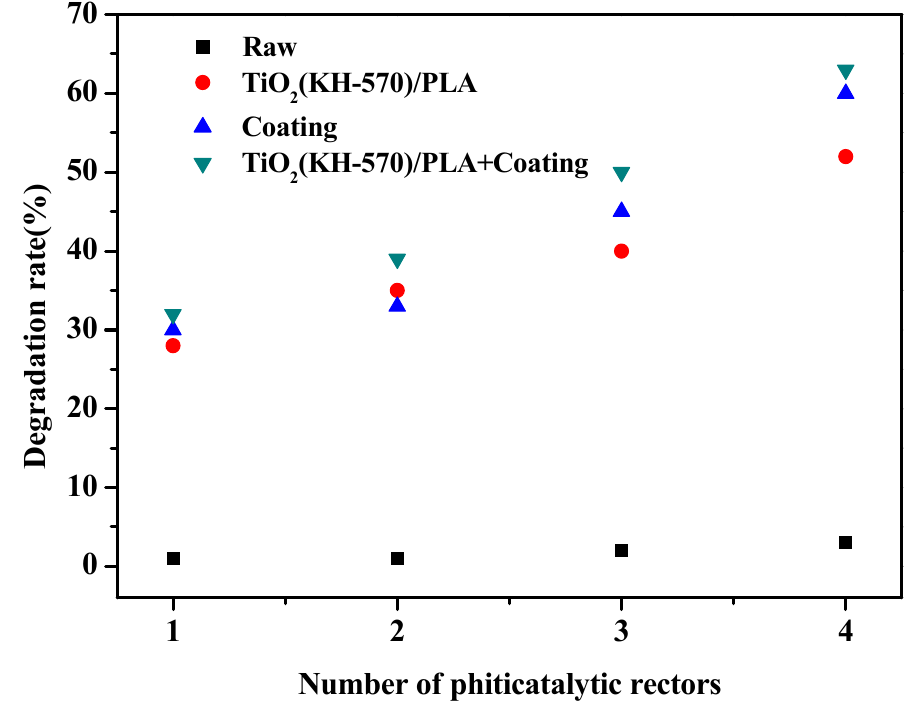
Figure 11. Treatment effect of water treatment equipment on the methylene blue solution.